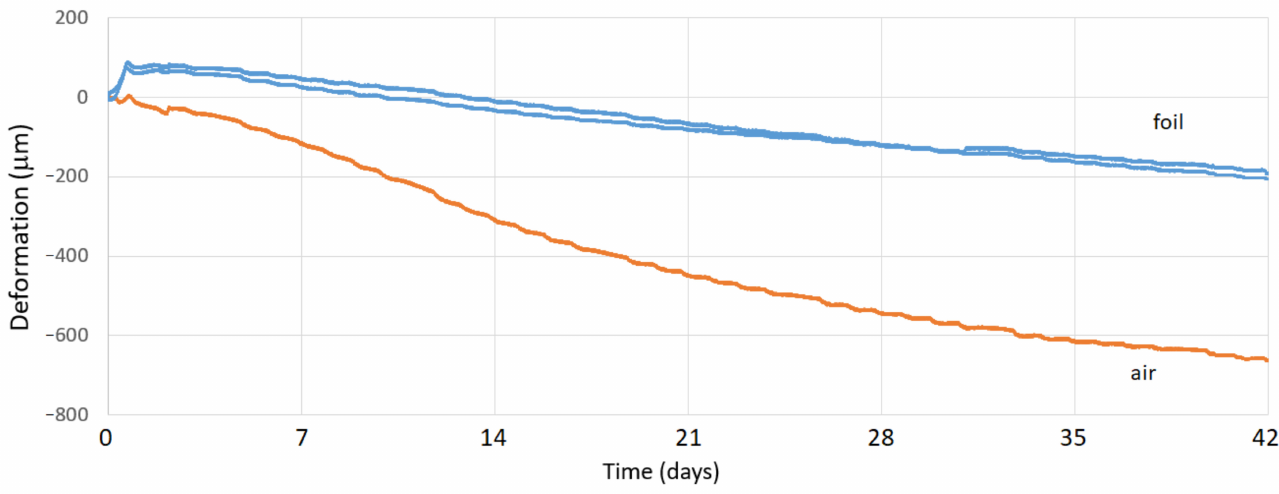
Figure 16. Volume changes in plain concrete over 42 days.